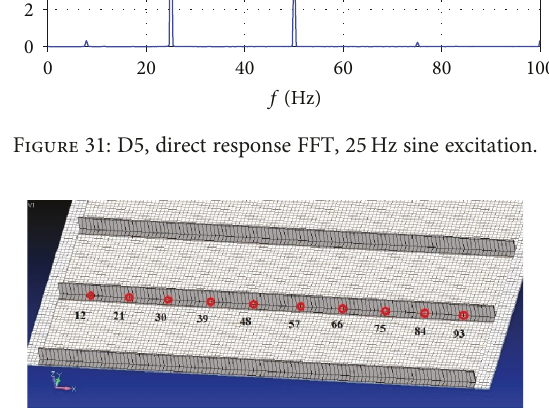
Figure 32: Positions of the measuring nodes for experimental superharmonic tests.